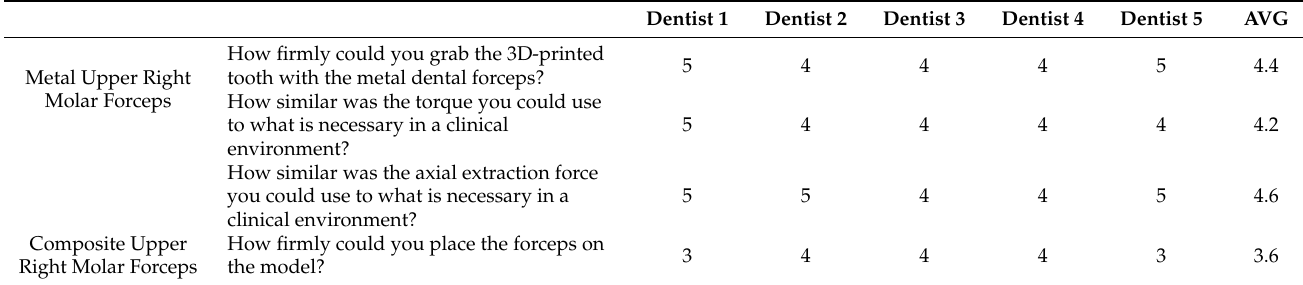
Table A1. Likert scale; summary of the results of the simulation of tooth